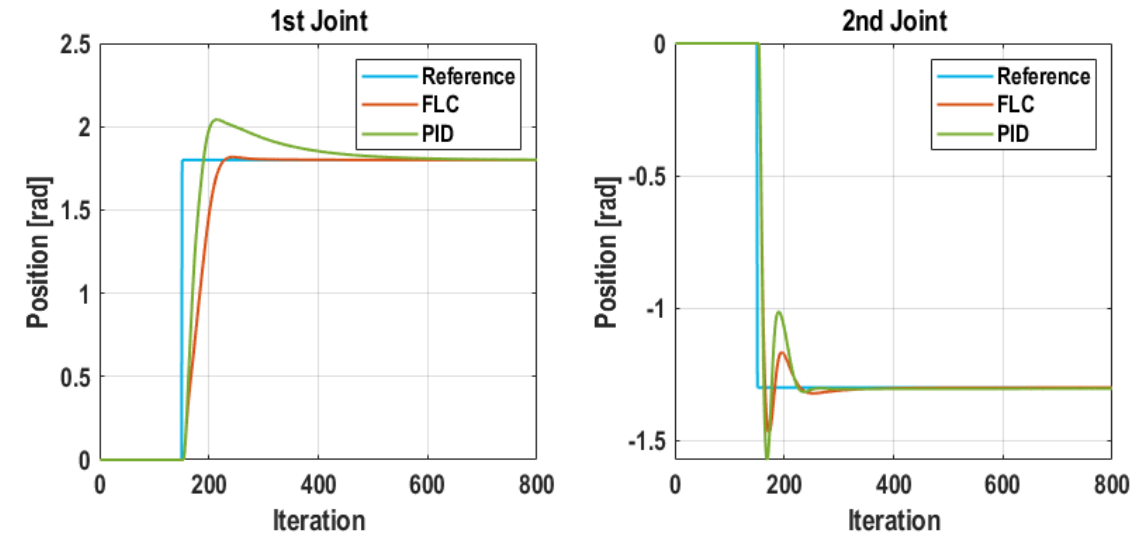
Figure 10. Response comparison to step reference of PID and Fuzzy Logic Controller over the robot HIL model. Table 8. IAE for both controllers: PID at the Edge Node and FLC at the Wireless Controller.